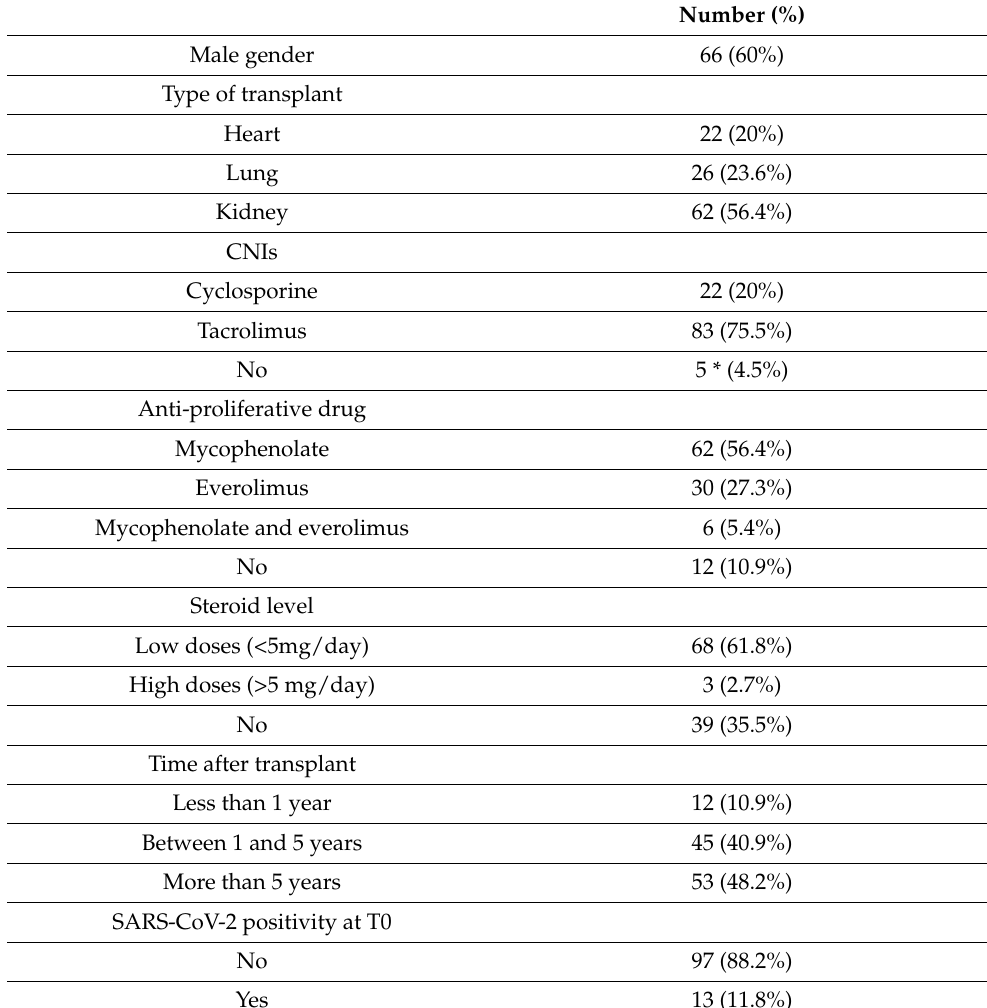
Table 1. Demographic and clinical characteristics of enrolled